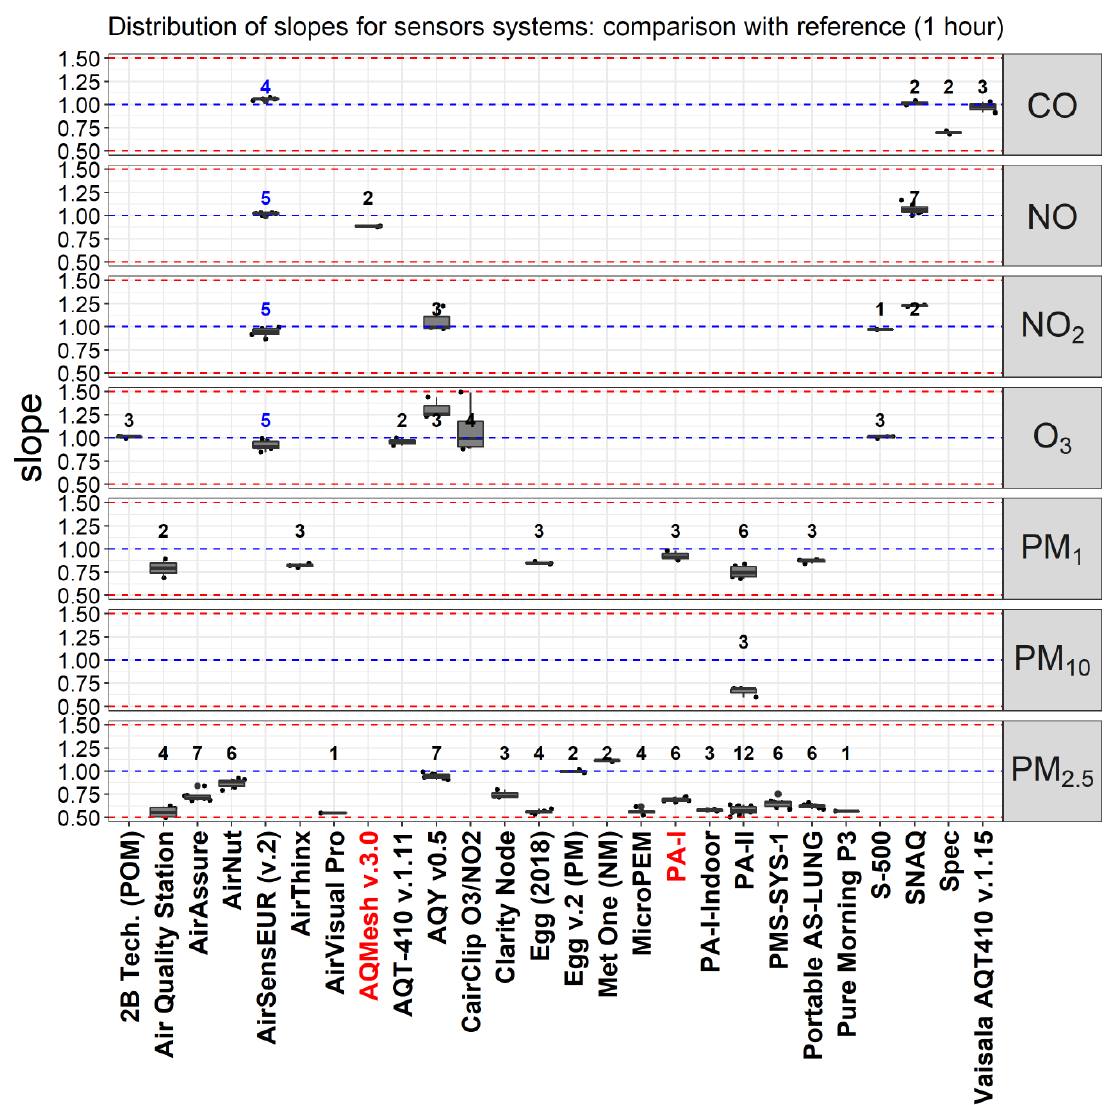
Figure A8. Distribution of slopes from the comparison of SSys against the reference. Only records with R 2 > 0.7 and 0.5 < slope < 1.5 are shown. Records were averaged over a time-scale of 1 h. Numbers in blue and black indicate the number of open source and black box records, respectively. Names of “living” and “non-living” sensors are indicated by black and red labels on the x-axis, respectively.